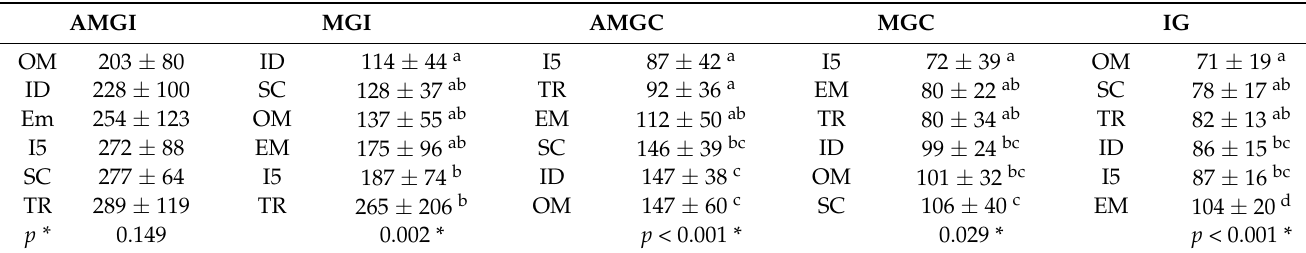
Table 1. Means ( µ m) and SDs for Absolute Marginal Gap at the Incisal Margins (AMGI), Marginal Gap at the Incisal Margins (MGI), Absolute Marginal Gap at the Cervical Margins (AMGC), and Average Internal Gap (IG) groups.